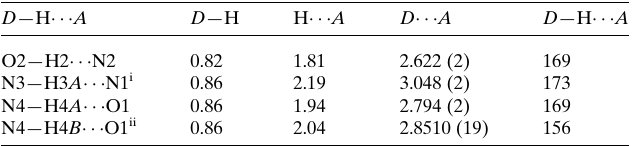
Table 1 Hydrogen-bond geometry (A˚ , (cid:4) ).